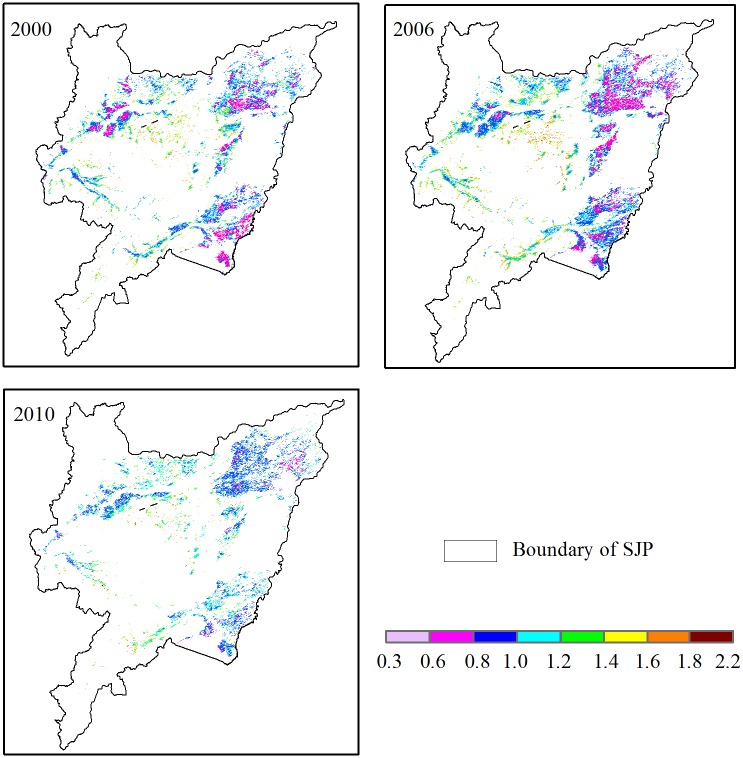
Spatial distribution of Ft in 2000, 2006, and 2010.